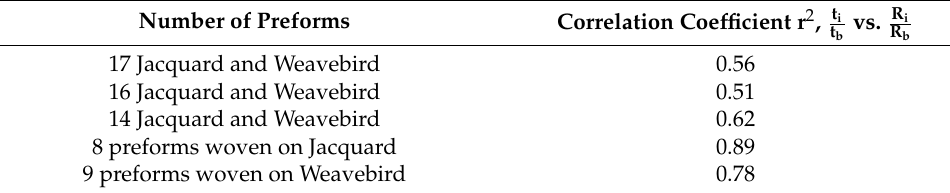
Table 11. Correlation coefficient and number of preforms by loom.